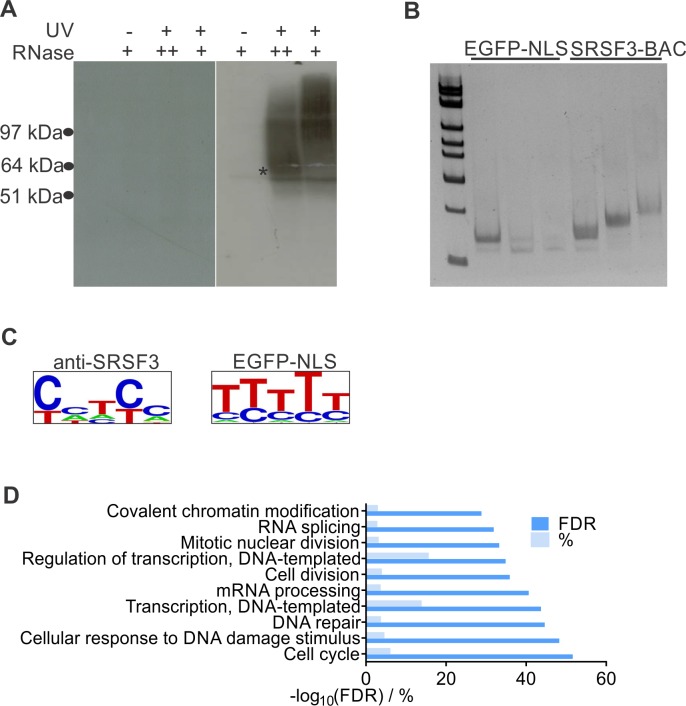
SRSF3 iCLIP in pluripotent cells.(A) Protein-RNA complexes isolated for SRSF3-GFP and control iCLIP library preparation. The star marks the position of SRSF3-GFP. The iCLIP library was isolated from a membrane piece above the star for both SRSF3-GFP and GFP-NLS. (B) Amplified iCLIP libraries after size selection. The two largest size fractions were pooled and sequenced, the smallest fraction omitted. (C) SRSF3 consensus binding motif determined from iCLIP conduction using anti-SRSF3 antibody in wild type (left) and GFP-antibody in GFP-only expressing (right) pluripotent cells. (D) Analysis of enriched GO terms among RNAs with significant SRSF3 crosslink sites.